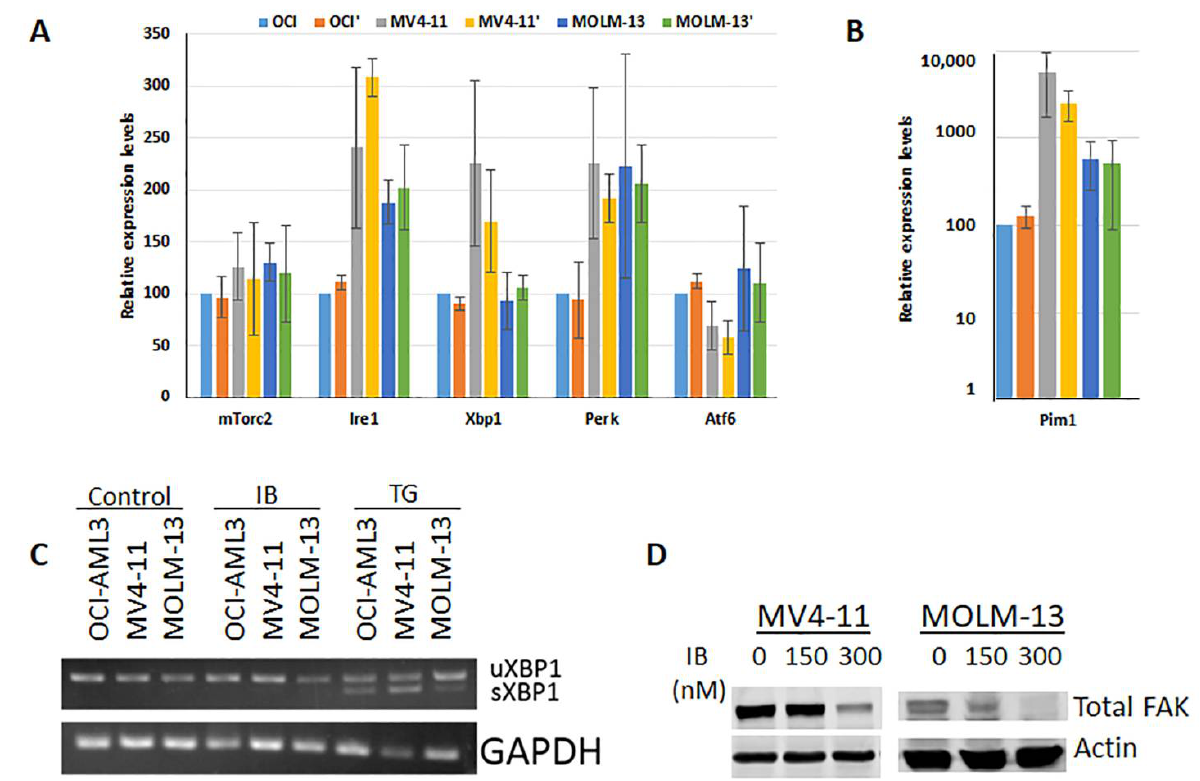
Figure 5. IB does not induce an unfolded protein response but does suppress expression of focal adhesion kinase. ( A ) A panel of genes related to the unfolded protein response were assayed by real-time qRT-PCR. The panel included mTorc2, Ire1, Xbp1, Perk, and Atf6. ( B ) The positive control for qRT-PCR is shown on a log scale y -axis since the Pim1 levels were comparably very high. n = 4 for all cell lines tested. p values were not significant (>0.05) for comparisons between IB treated and untreated samples. However, not indicated on the graph: Ire1 and Pim1 were significantly different ( p < 0.05) relative to OCI-AML3 cells under all conditions; Xbp1 was only significant for untreated MV4-11 cells; Perk was only significant for treated MV4-11 and treated MOLM-13 cells; Atf6 was only significant for untreated MV4-11 cells. ( C ) In addition to testing gene expression changes typically present in UPR, cleavage of Xbp1 was also examined following IB treatment. Thapsigargin TG was the positive control. ( D ) In order to test for a general cell death mechanism, total FAK levels were also assessed following 24 h IB treatment in both MV4-11 and MOLM-13 Flt3-ITD + cells.